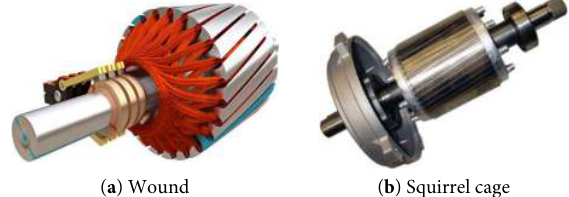
Fig. 9 Two types of IM